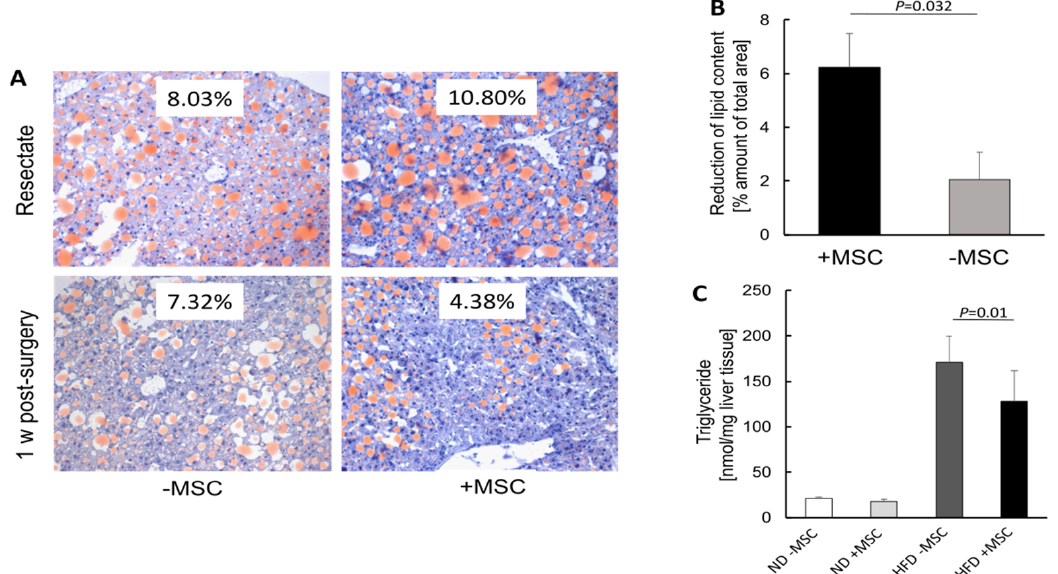
Figure 2. MSC treatment ameliorates lipid content in livers of high-fat-diet-fed mice; ( A ) lipid droplets were detected histochemically by staining with Sudan III in liver slices from the resectates before PBS ( − MSC) or MSC (+MSC) application (cf. Materials and Methods) and 1 week post- surgery; pictures are representative for 5 and 6 different animals in the MSC group and in the group without MSC treatment, respectively; the percentage amount of lipid is shown in the insets (orig. magnification: 20×); ( B ) quantitative image analysis of pictures shown representatively in ( A ); values are means ± SEM and were calculated as the difference between lipid content at the time of surgery (resectate) and 1 week after application of either PBS ( − MSC) or MSC (+MSC). This calculation was introduced to account for the different starting points in different animals featuring various degrees of NASH; ( C ) liver triglycerides were determined biochemically using the Triglyceride Assay Kit (Abcam); values are means ± SD from 3 (ND − MSC), 4 (ND +MSC), 9 (HFD − MSC) and 9 (HFD + MSC) animals per group; in ( B , C ), the two-sided Student´s t -test was applied for calculation of significance.